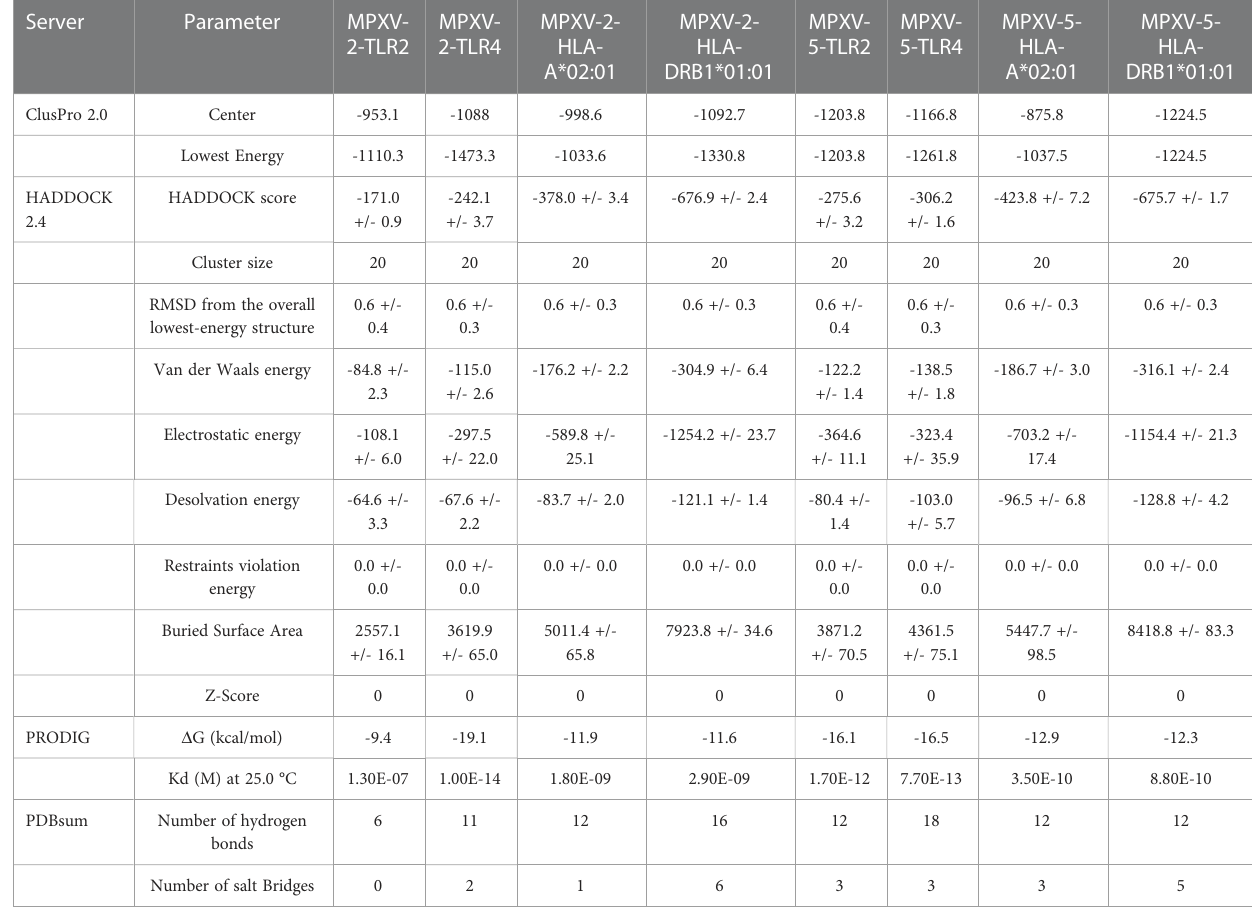
TABLE 5 Docking analysis of vaccine-receptors